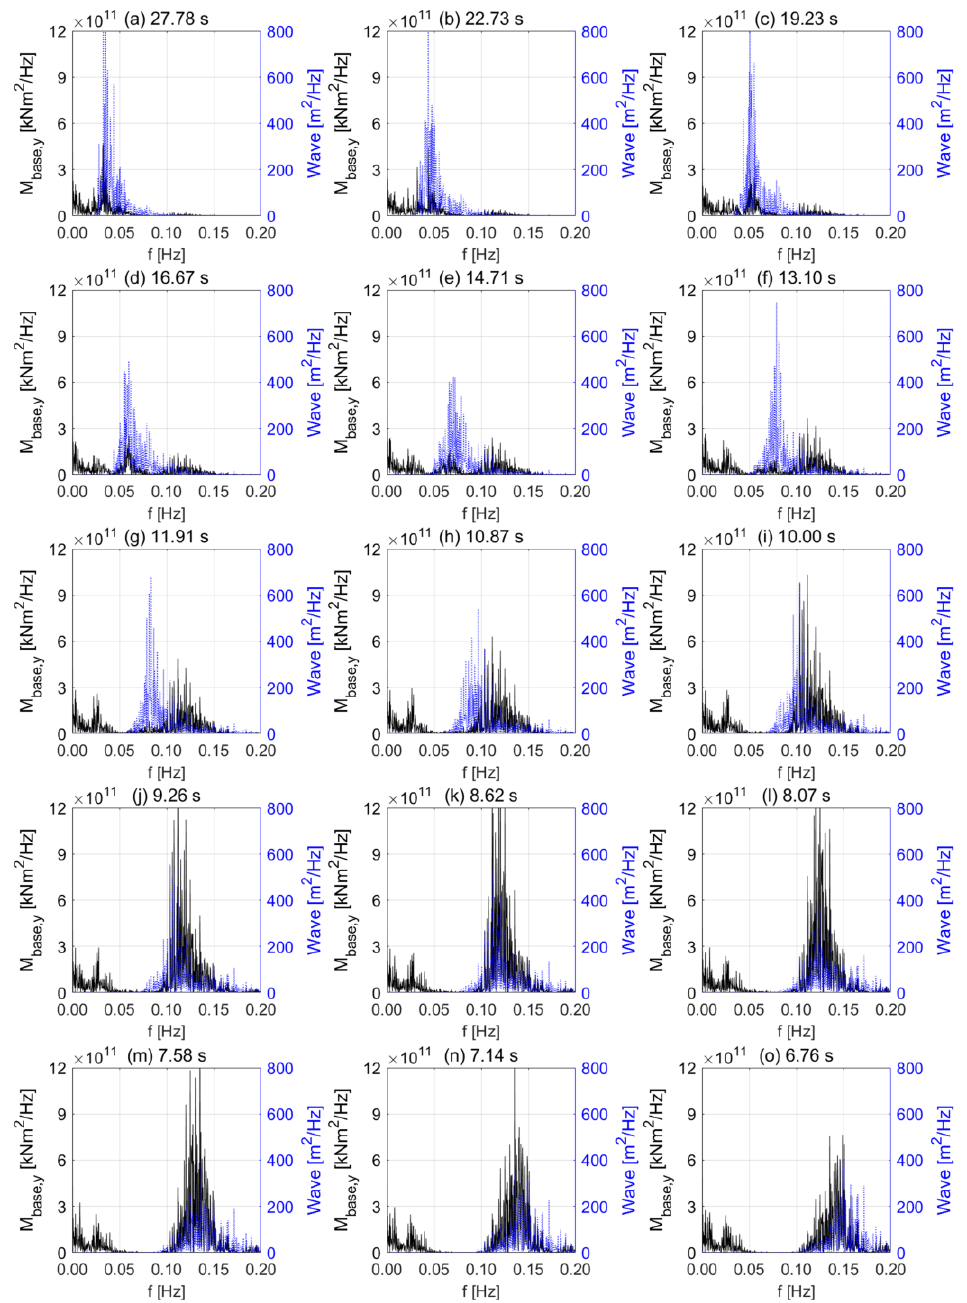
Figure 9. FFT results of tower-base pitch moments (black) and waves (blue) according to wave peak periods.